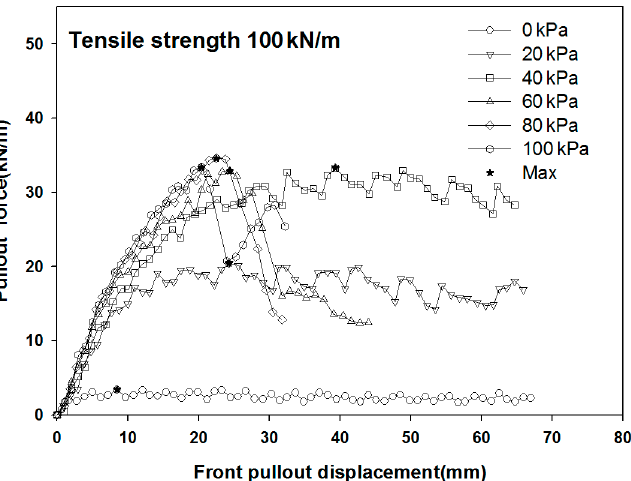
Figure 6. Front pullout displacement versus pullout force with confining stress (T g = 100 kN/m).